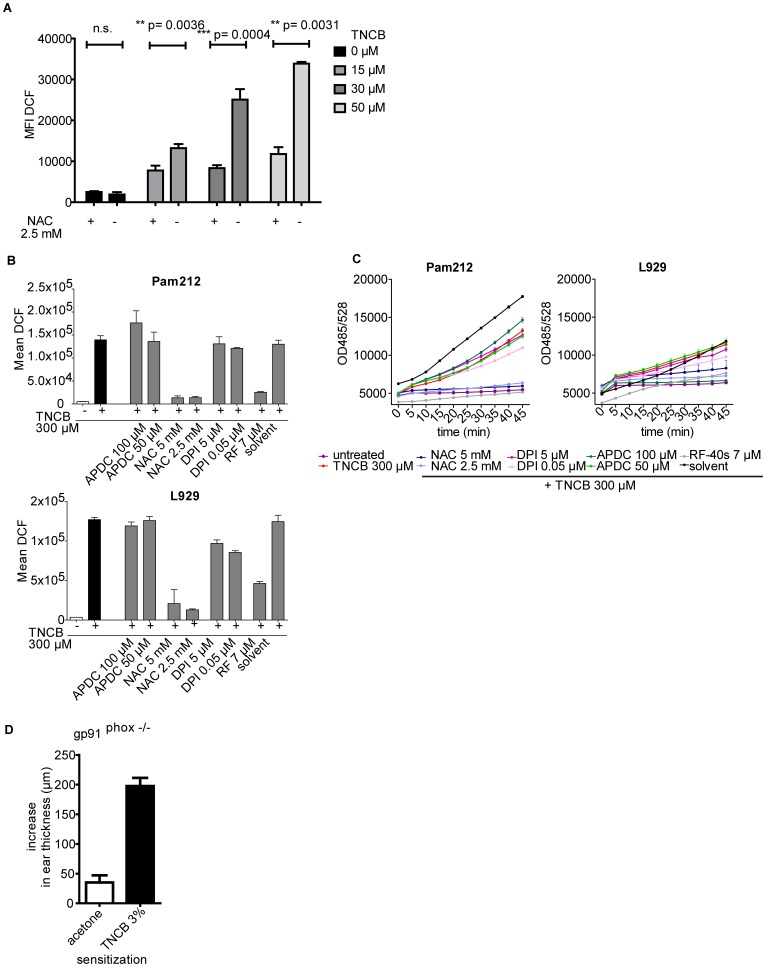
Source and kinetics of TNCB induced ROS production in vitro.
(A) DCF fluorescence after incubation of BMDC with different concentrations of TNCB for 2 h either with or without NAC treatment was analyzed by flow cytometry. Data show mean fluorescence intensity of DCF +/− SD of triplicate stimulations. One of two independent experiments is shown. (B) Pam212 or L929 cells were left untreated (−) or stimulated with TNCB (300 µM) after pre-treatment with antioxidants NAC or RF-40s for 1 h. In addition, the influence of the mitochondria specific antioxidant APDC and the NADPH oxidase specific antioxidant DPI was analyzed under the same conditions. DCF fluorescence was analyzed 5, 10, 15, 20, 25, 30, 35, 40 and 45 min after TNCB addition. Data show mean fluorescence as calculated comprising all timepoints (B) or kinetics of fluorescence (C) +/− SD of quadruplicate wells from one representative experiment out of three. (D) gp91phox −/− mice were sensitized with TNCB (3%) or mock treated with acetone. 5 days later, mice were challenged with TNCB (1%) and increase in ear thickness was measured 24 h later. Data shows mean increase in ear thickness +/− SD of n = 3 mice/group. One representative of three independent experiments is shown.